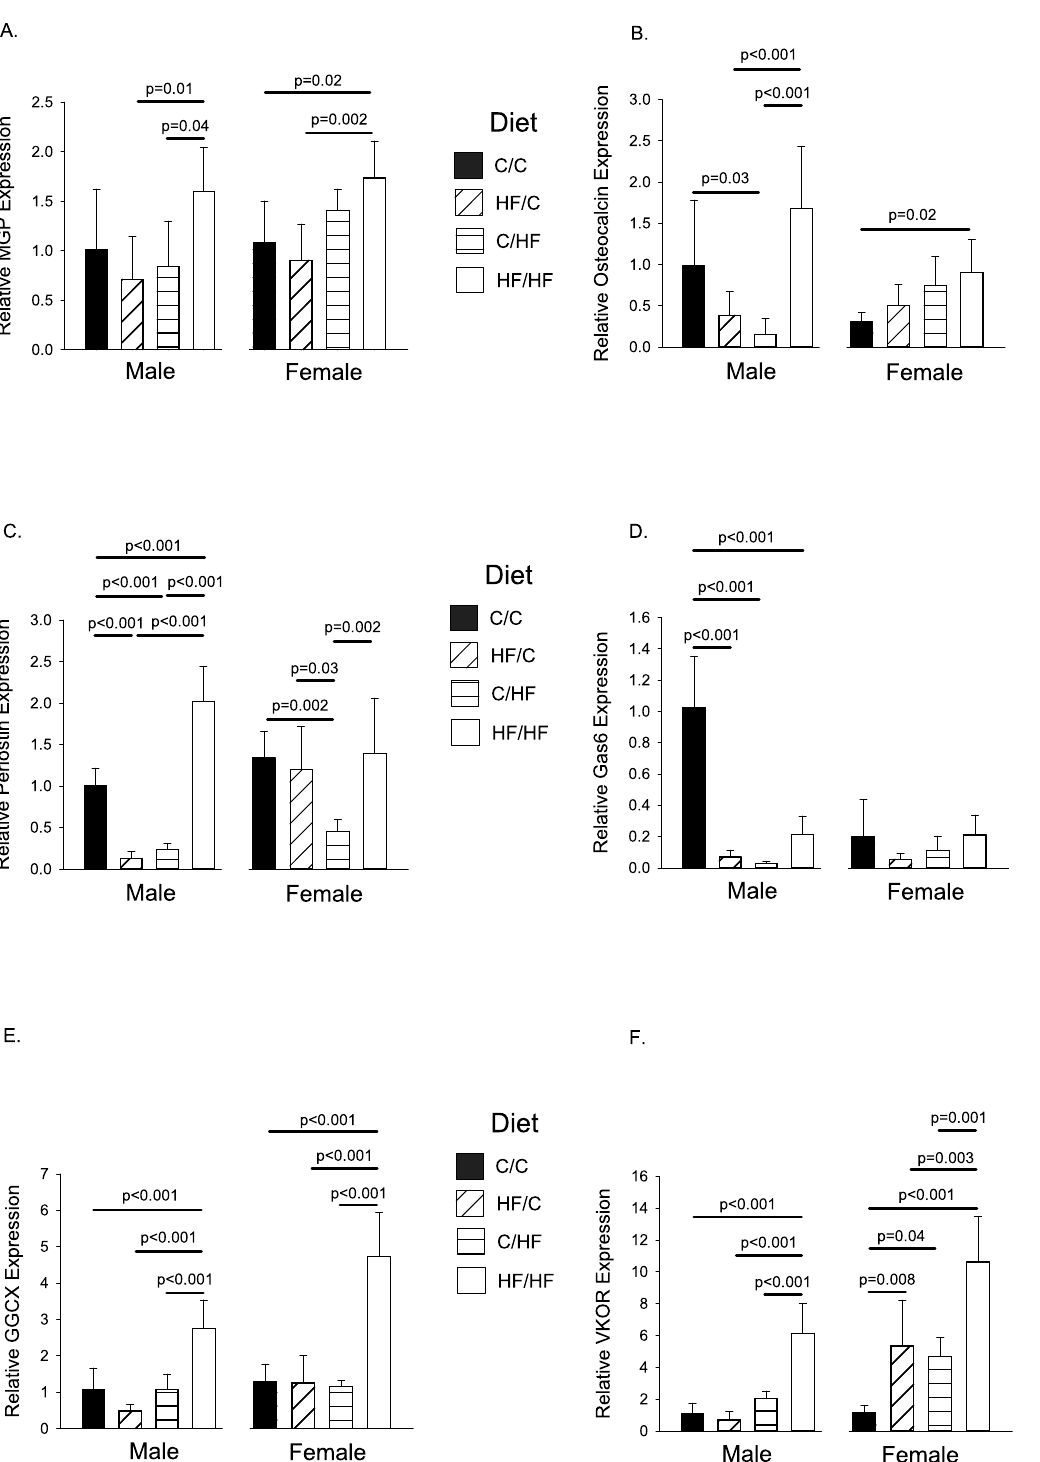
Fig 5. Mean Relative Gene Expression Levels in Femur for Thirty Week Old Mice. Gene expression was determined by qPCR. Graphs show gene expression for (A). MGP , (B). Osteocalcin , (C). Periostin , (D). Gas6 , (E). Ggcx , and (F). Vkor . Gene expression is shown relative to male C/C group. For all groups, n = 5 – 7 per group. Graphs show mean plus 95% confidence